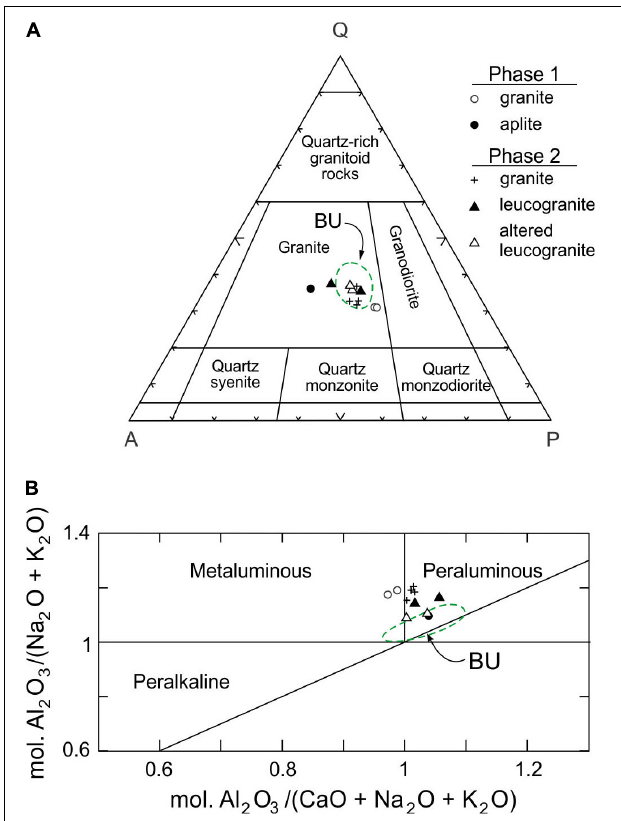
FIGURE 8 | (A) Mesonormative quartz-alkali feldspar-plagioclase (QAP) ternary classification diagram used to characterize the modal composition of the plutonic rocks. It shows the Tukhum granitic rocks whereas the dashed green curve outlines the field (BU) for the Bayan-Ulan pluton. (B) Al 2 O 3 /(Na 2 O + K 2 O) versus Al 2 O 3 /(CaO + Na 2 O + K 2 O; in mole%) diagram for TP granitic rocks defining the ranges of peraluminous, metaluminous, and peralkaline plutonic rocks. The dashed green line delineates the field (BU) for the rocks from Bayan-Ulan pluton.